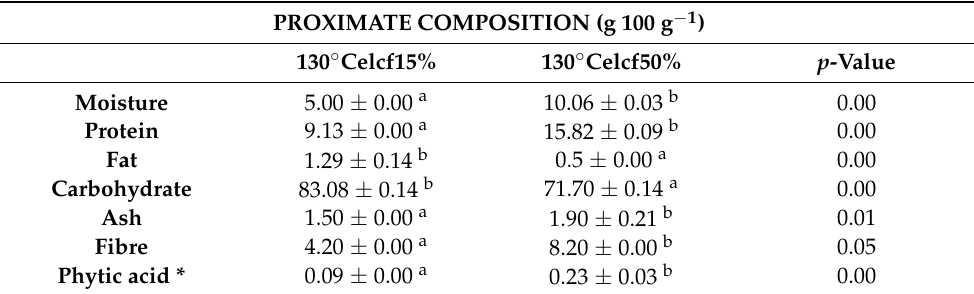
Table 4. Proximal composition (g 100 g − 1 ) of flours extruded at 130 ◦ C.